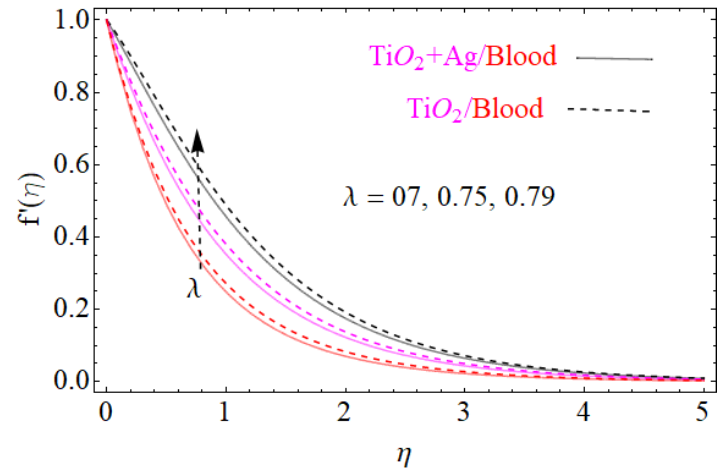
Figure 4. Effect of stretching parameter on velocity profile.